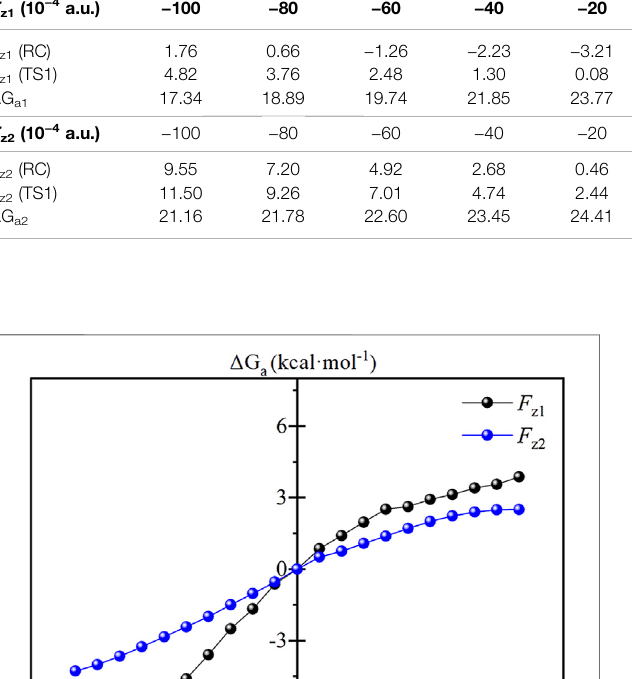
TABLE 3 | The dipole moments of the RC, TS1 and the energy barrier ( Δ G, kcal · mol − 1 ) of CH 4 oxidation catalyzed by Fe(IV)-Oxo-Cz under different electric fi eld intensities. − 4 a.u.) F z1 (10